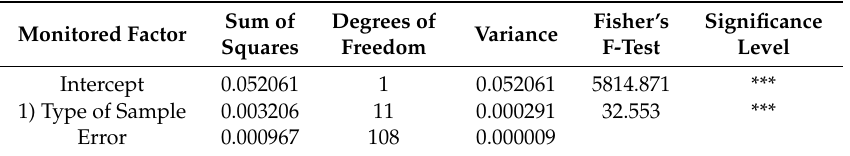
Table 9. Statistical evaluation of the e ff ect of the factors and their interaction on the coe ffi cient of wood bendability ( K bendB ) for beech and NWC on the bottom.